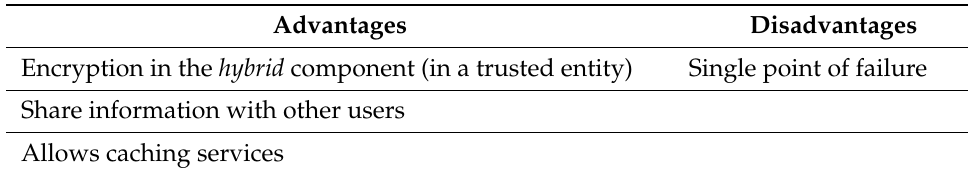
Table 2. Advantages and disadvantages of hybrid cloud